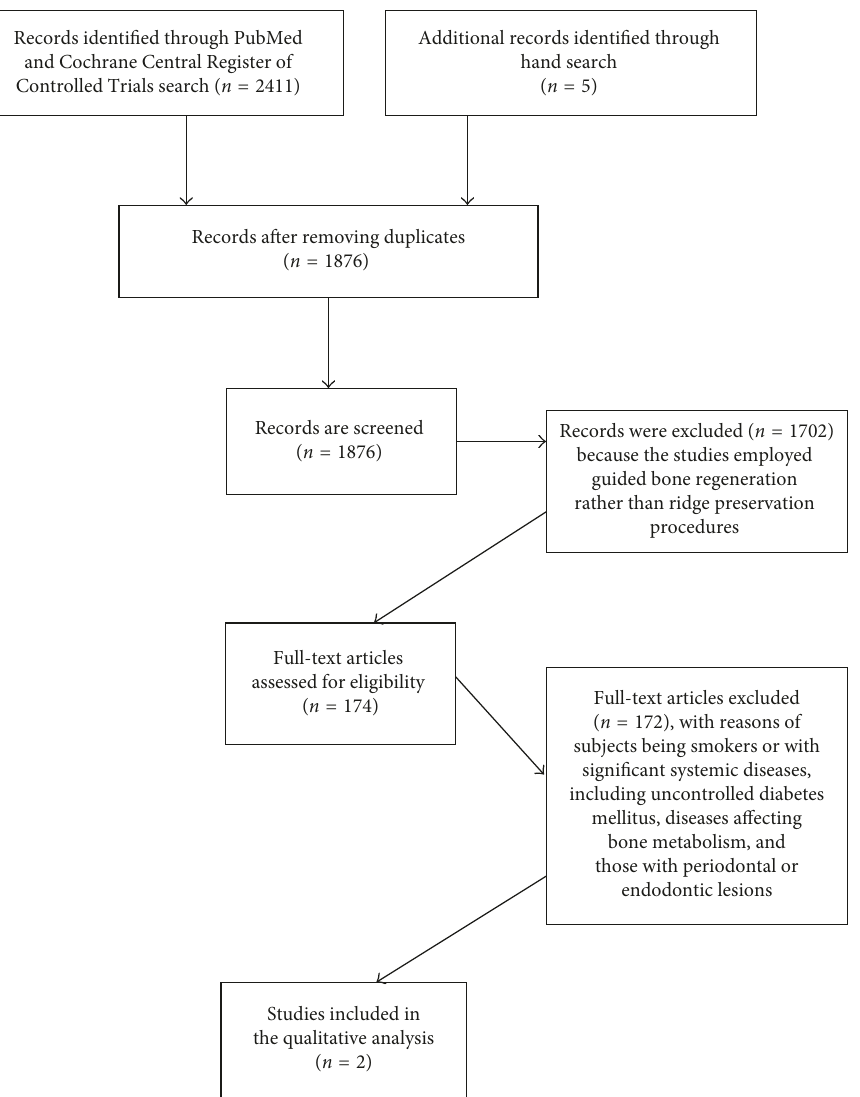
Figure 1: The PRISMA flow